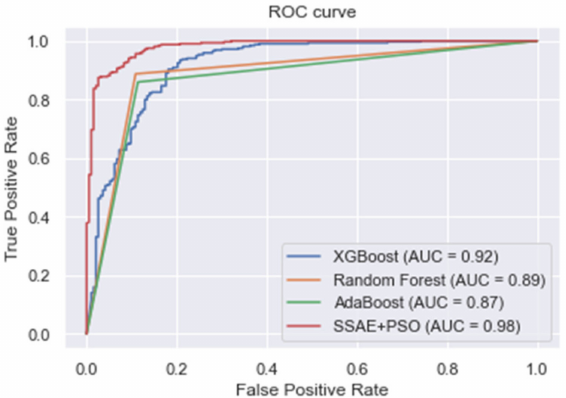
Figure 3. ROC curve of the classifiers using the Cleveland dataset.